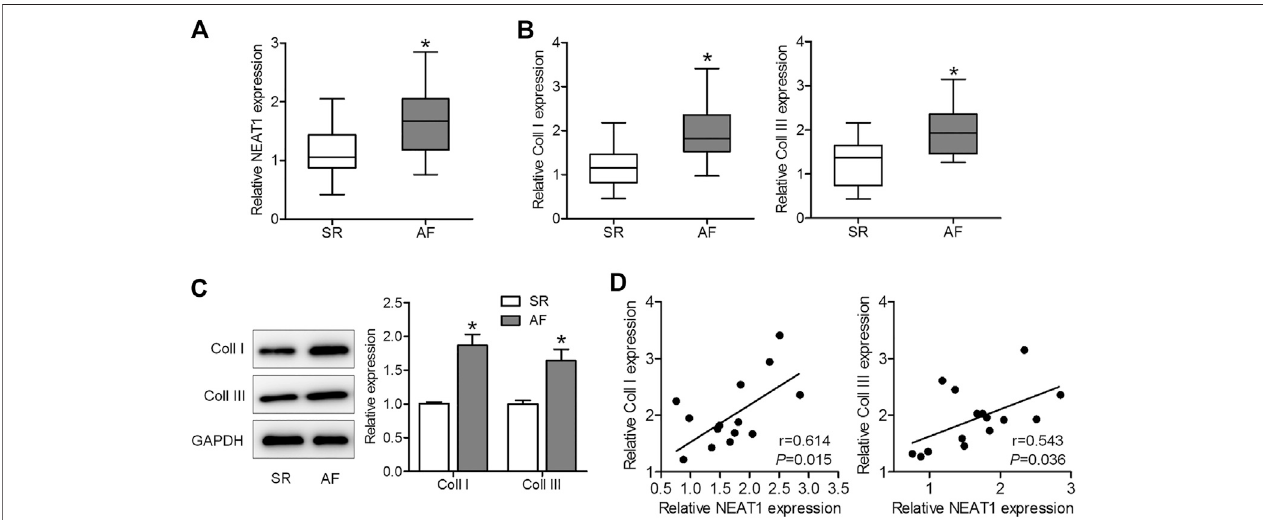
FIGURE 1 | NEAT1 expression is increased in patients with AF and is positively associated with collagen I (coll I) and collagen III (coll III). (A) NEAT1 expression in right atrial tissues of patients with AF (n (cid:1) 15) and those with SR (n (cid:1) 13) was detected using qRT – PCR analysis. (B) The mRNA expression of coll I and coll III in human right atrial tissues was determined using qRT – PCR. (C) The protein expression of coll I and coll III in human atrial tissues was determined using western blotting. (D) Correlations of NEAT1 with coll I and coll III were analyzed. * p < 0.05. Data represent mean ± SD from three independent